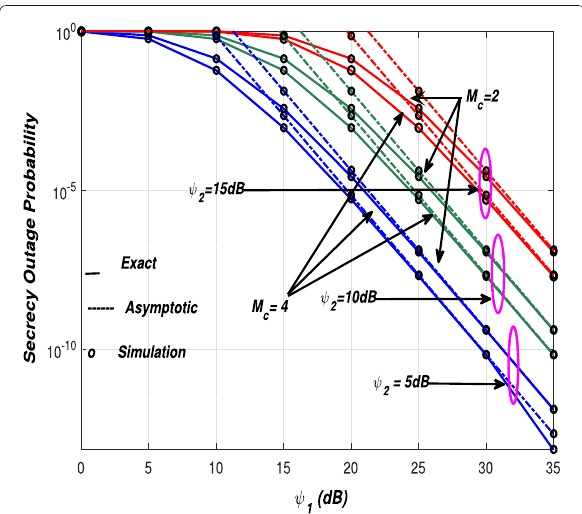
Fig. 5 Average number of active MRC branches. Active MRC branches versus output SNR for different numbers of antennas M with M c = 2 and (cid:3) 1 = 10